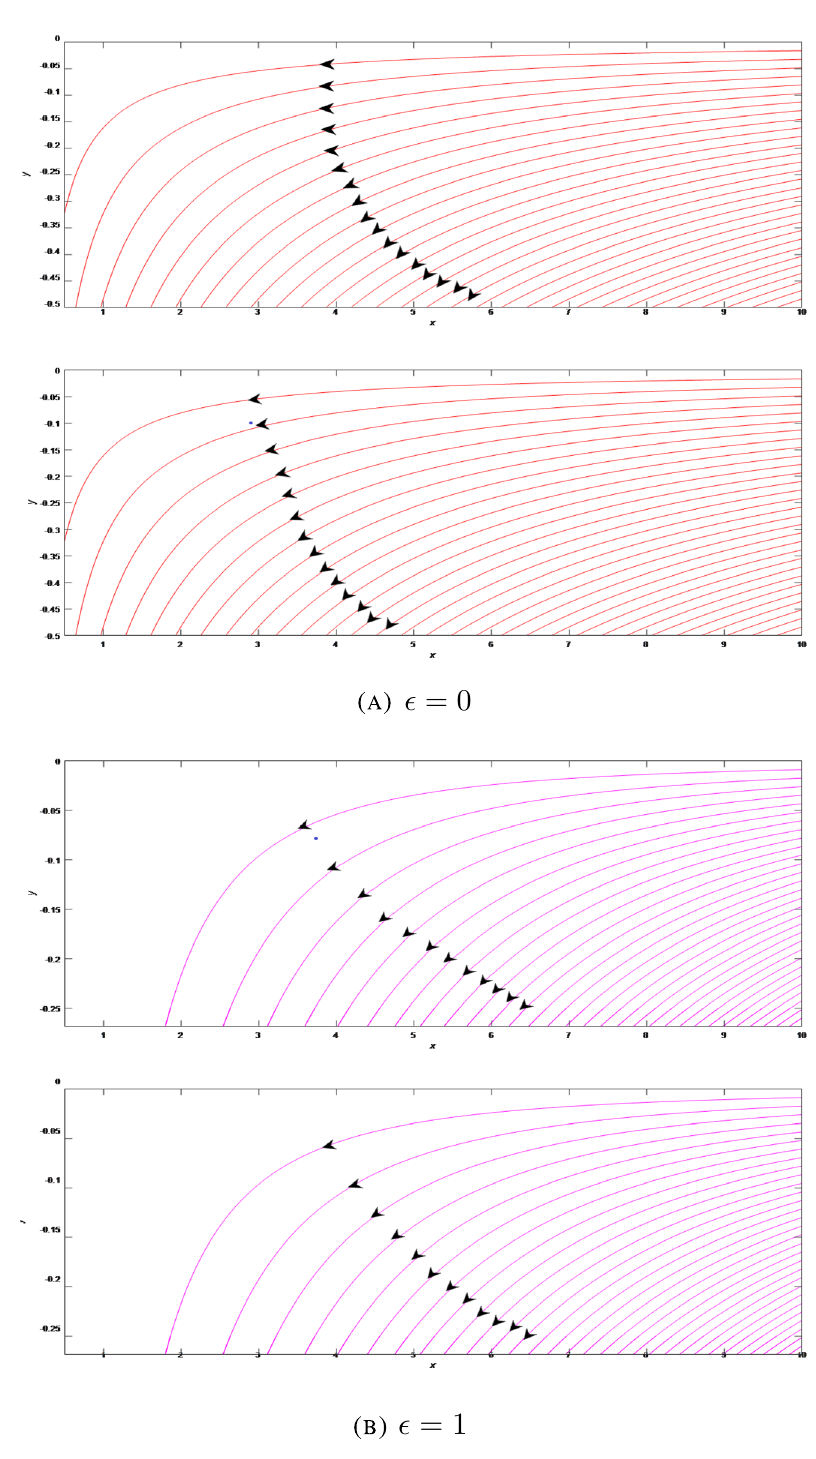
1 and t 5 for two-dimensional and = =